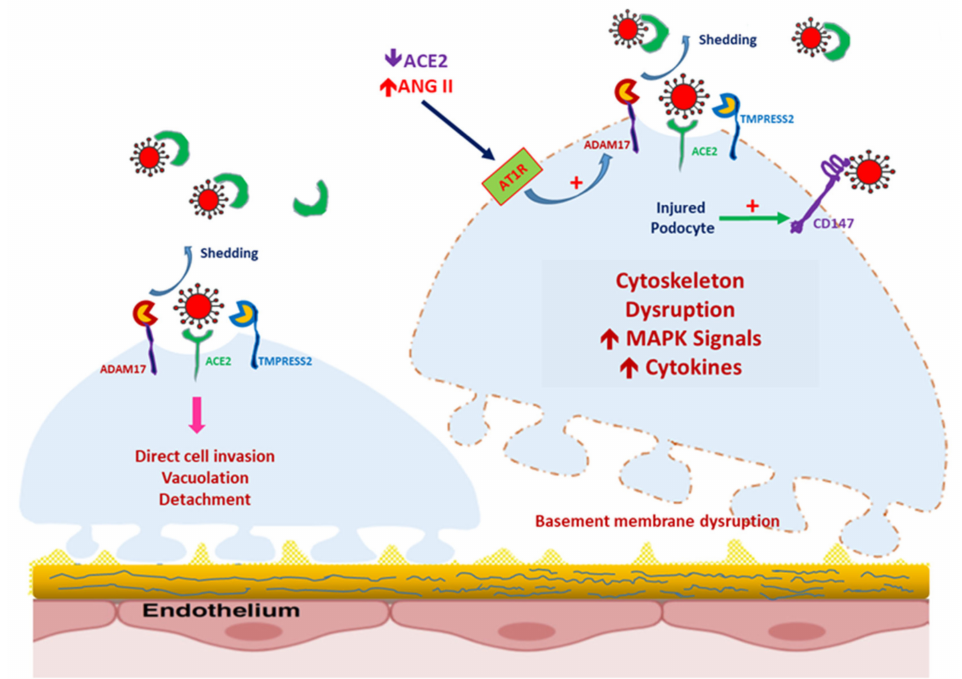
Figure 3. Severe acute respiratory syndrome coronavirus 2 (SARS-CoV-2)-induced